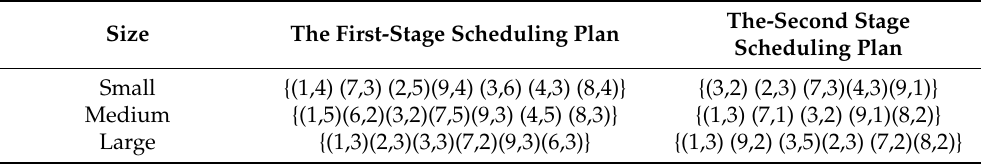
Table 10. Scheduling plan for small, medium, and large vehicles at each rescue point. Size